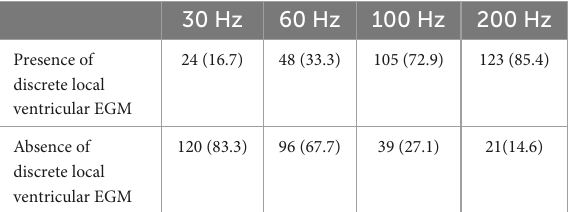
TABLE 2 Detection of discrete local ventricular EGM at different high-pass filter